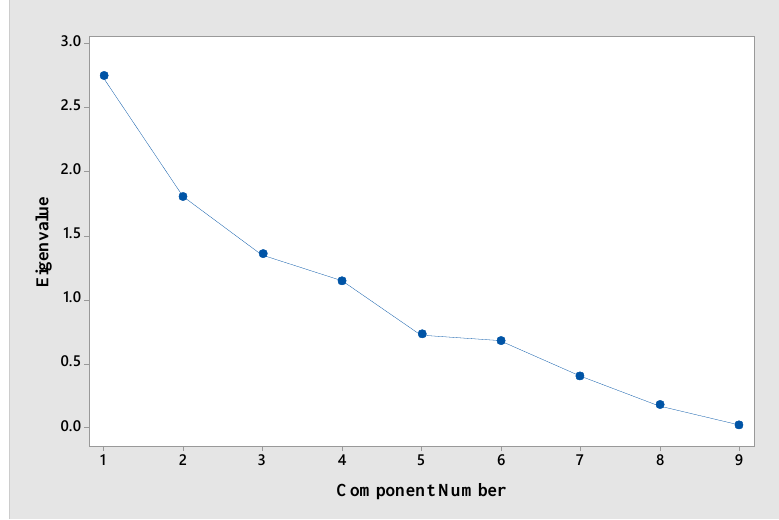
Fig. 1. The eigenvalue for each PSF.